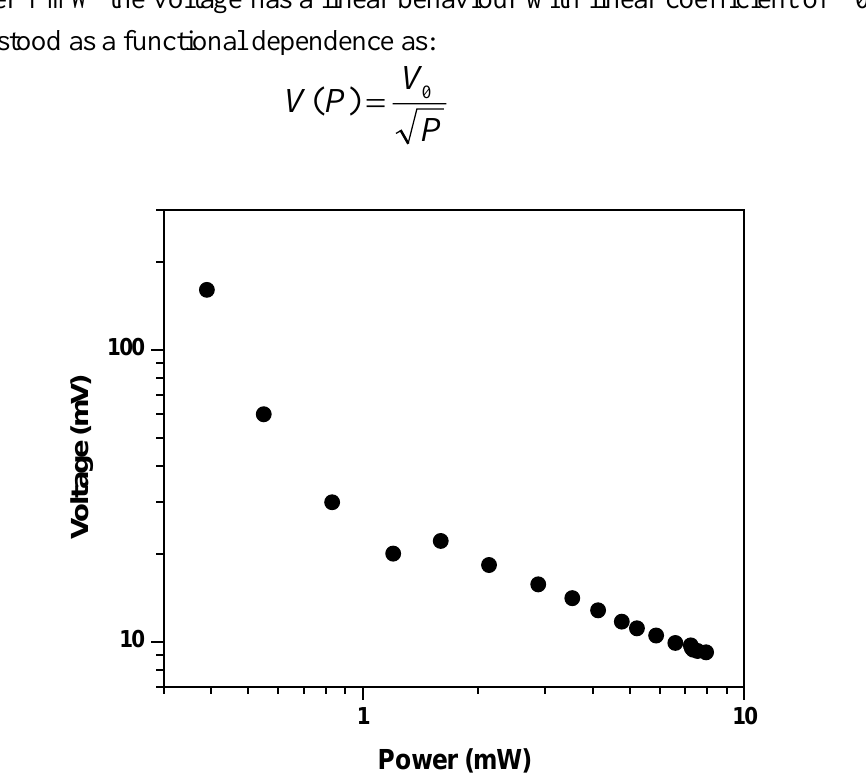
Figure 1. LDR voltage as function of the continuous light power. For values higher than 1 mW the curve is linear. The linear fit inclination calculated is –0.55 ± 0.01. The fit was done with the Origin